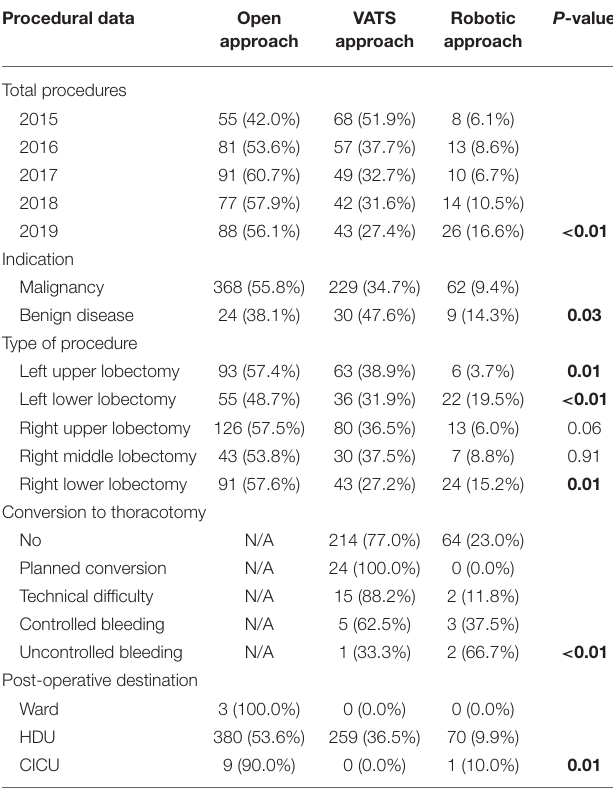
TABLE 3 | Procedural data per surgical